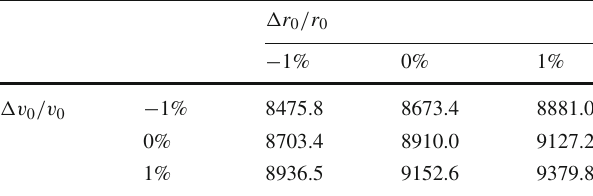
Table1 Newtonianperiod T N (inseconds)fortheproposedsetup(with m P = 0 . 75 × 10 − 4 ) for variations of the initial conditions at the percent level, with the benchmark corresponding to r 0 = 111 . 8 μ m, ˙ r 0 = 30 . 6